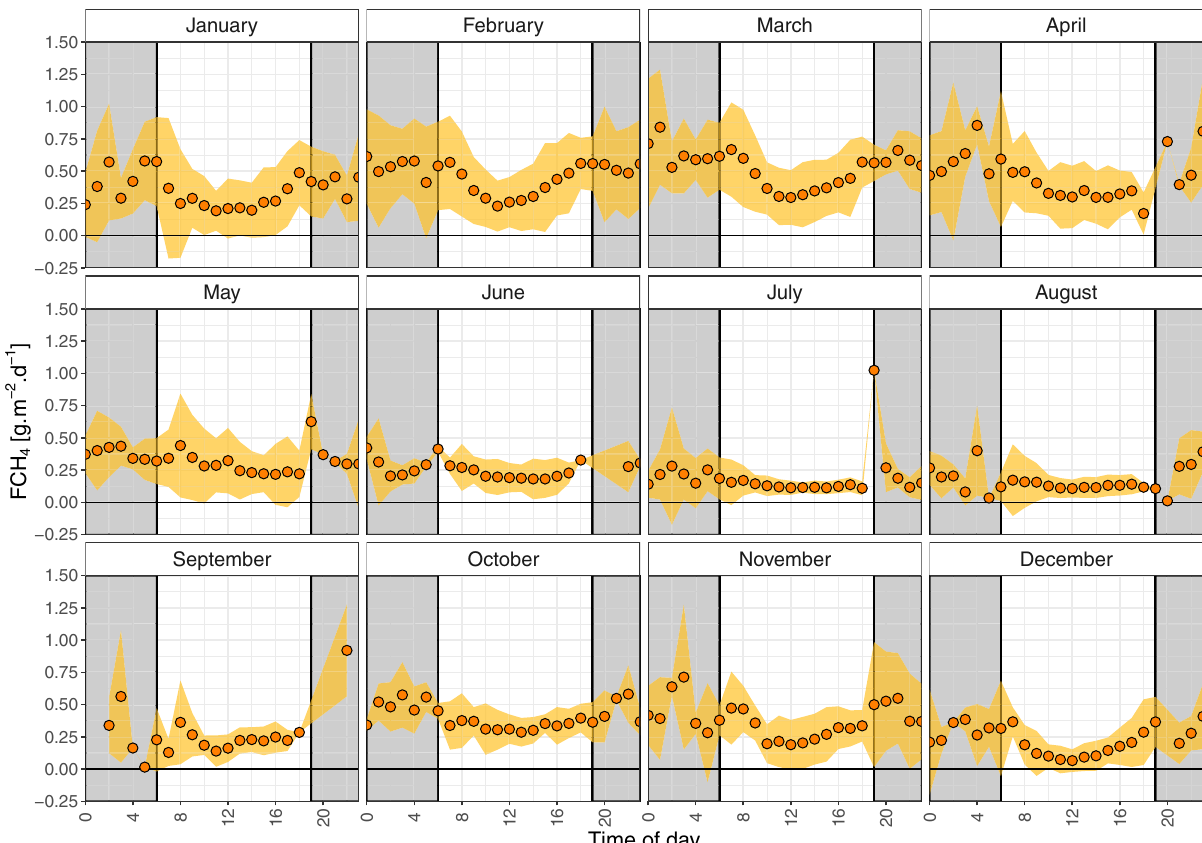
Fig. 2 Diel cycles of methane fl uxes measured by eddy-covariance over Cyperus papyrus . Measurements taken at Guma Lagoon (18°57 ′ 53.01 ″ S; 22°22 ′ 16.20 ″ E) in the permanently fl ooded part of the Okavango Delta from August 2017 to August 2020. Half-hourly methane fl ux data points (FCH 4 ) were averaged to hourly values on a monthly basis using all available data for the period August 2017 – August 2020 were used. The coloured ribbon represents the standard deviation of the mean and the grey rectangles symbolise